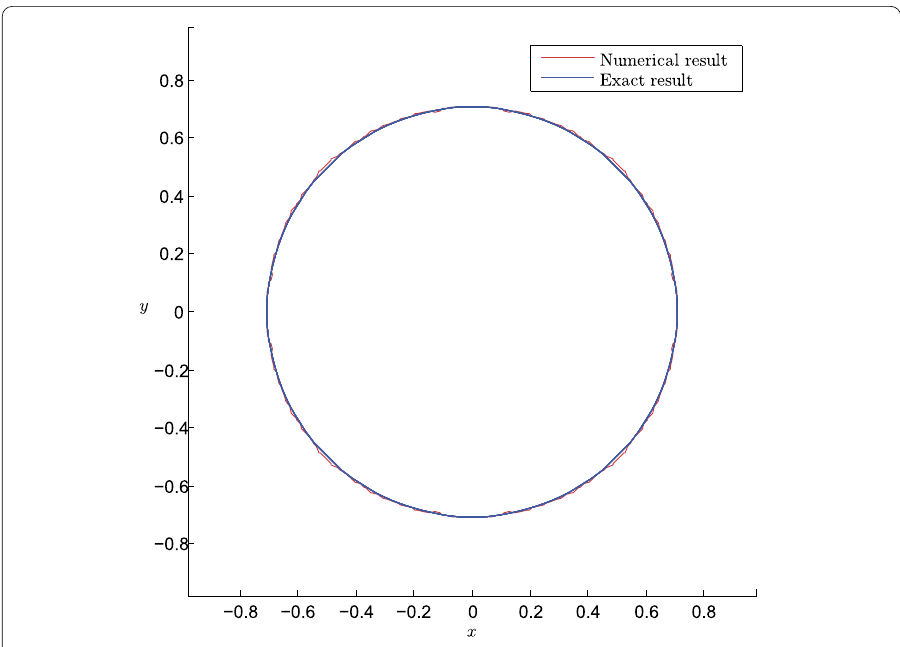
Figure 1 The comparison between numerical result and exact result